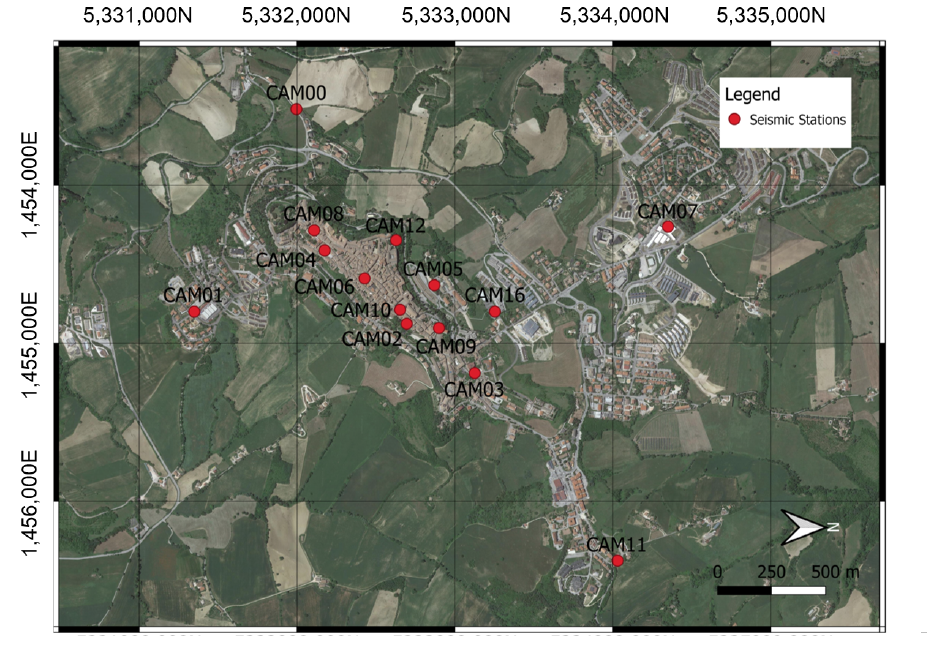
Figure 9. Position of the MEMS accelerometric stations deployed in the framework of the ARCH project (adapted from